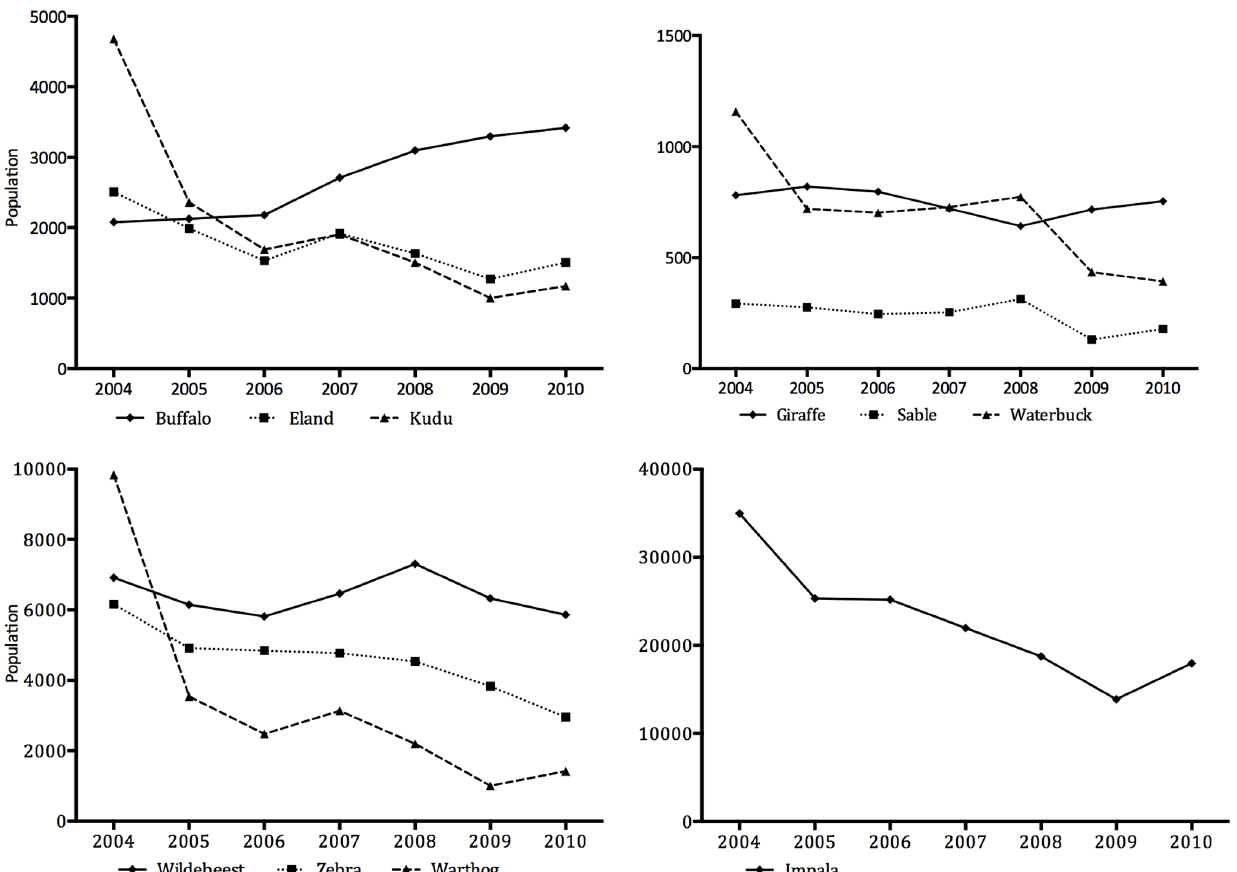
Figure 1. Population trends of ten key herbivore species in Save´ Valley Conservancy from 2004 to 2010.